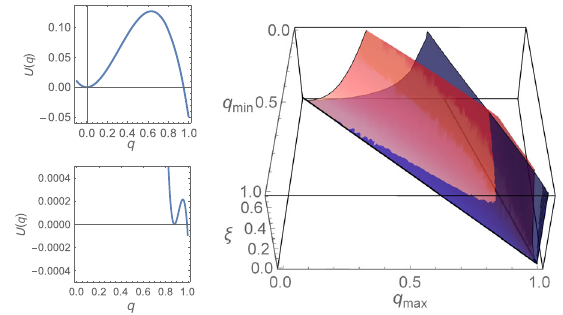
FIG. 6. Left panels: Potential barrier between the metastable and the ground state, Eq. (4), corresponding to s ¼ 1 for two pairs of ; q values ð q equal to (0, 0.633) (upper plot) and (0.88, min max Þ 0.955) (lower plot). Right panel: Scaling exponent of the optimal computation time of quantum annealing (red) [see Eqs. (6) and (19)] and simulated annealing (blue) given by ð 1 =N Þ log τ , with τ given by Eq. (A2) as a function of the location of the metastable minimum q and the top of the barrier q . The lower of the two min max surfaces corresponds to the shorter computation time. QA is advantageous for a range of parameters corresponding to suffi- ciently narrow potential barriers. Solid lines in the plane S ¼ 0 3 q q correspond to q and q (under both surfaces 2 min ¼ max min ¼ max in the figure) outlining the range of possible potentials in the cubic model Eq.